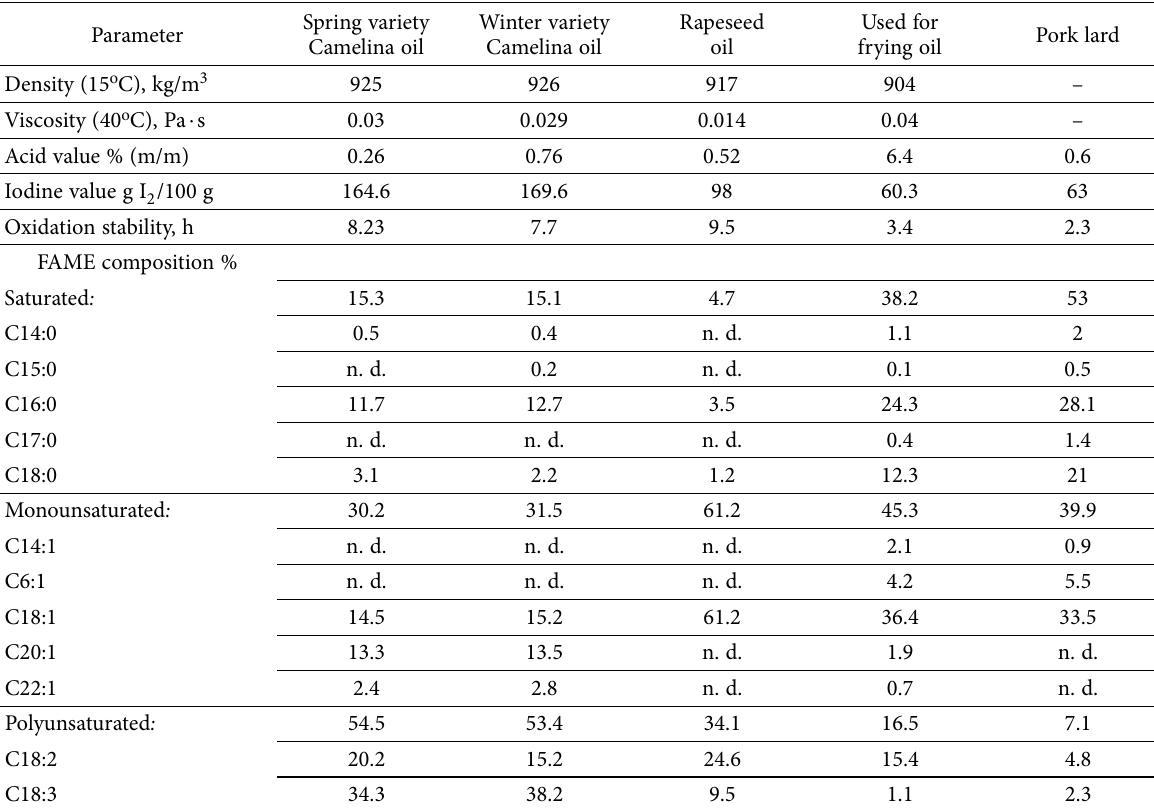
Table 1. The physical and chemical characteristics of oils and fats